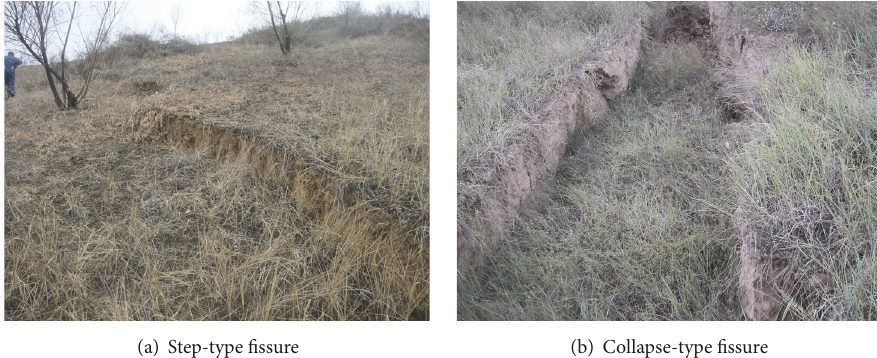
Figure 2: Vegetation growth after generation of nondamaging surface fissures.